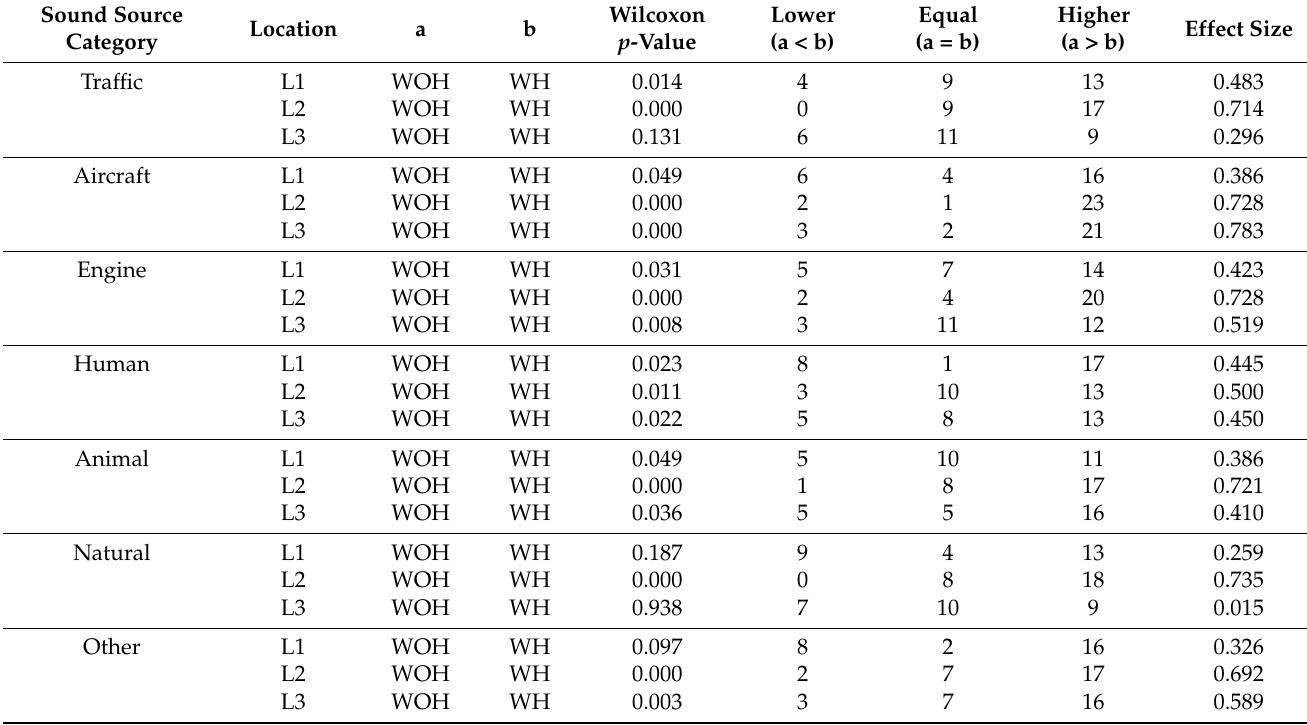
Table 2. Wilcoxon signed-rank test results ( p -value and comparison of ratings between paired variables) of the appraisals of the sound sources (sounds of road traffic, aircraft, engines, humans, animals, naturals, and others) for the scenarios with (WH) and without helicopter noise (WOH). Results are shown for the three locations under study (L1, L2, and L3). For the analysis of the participants’ appraisals, “a” is the first, and “b” is the second variable of the